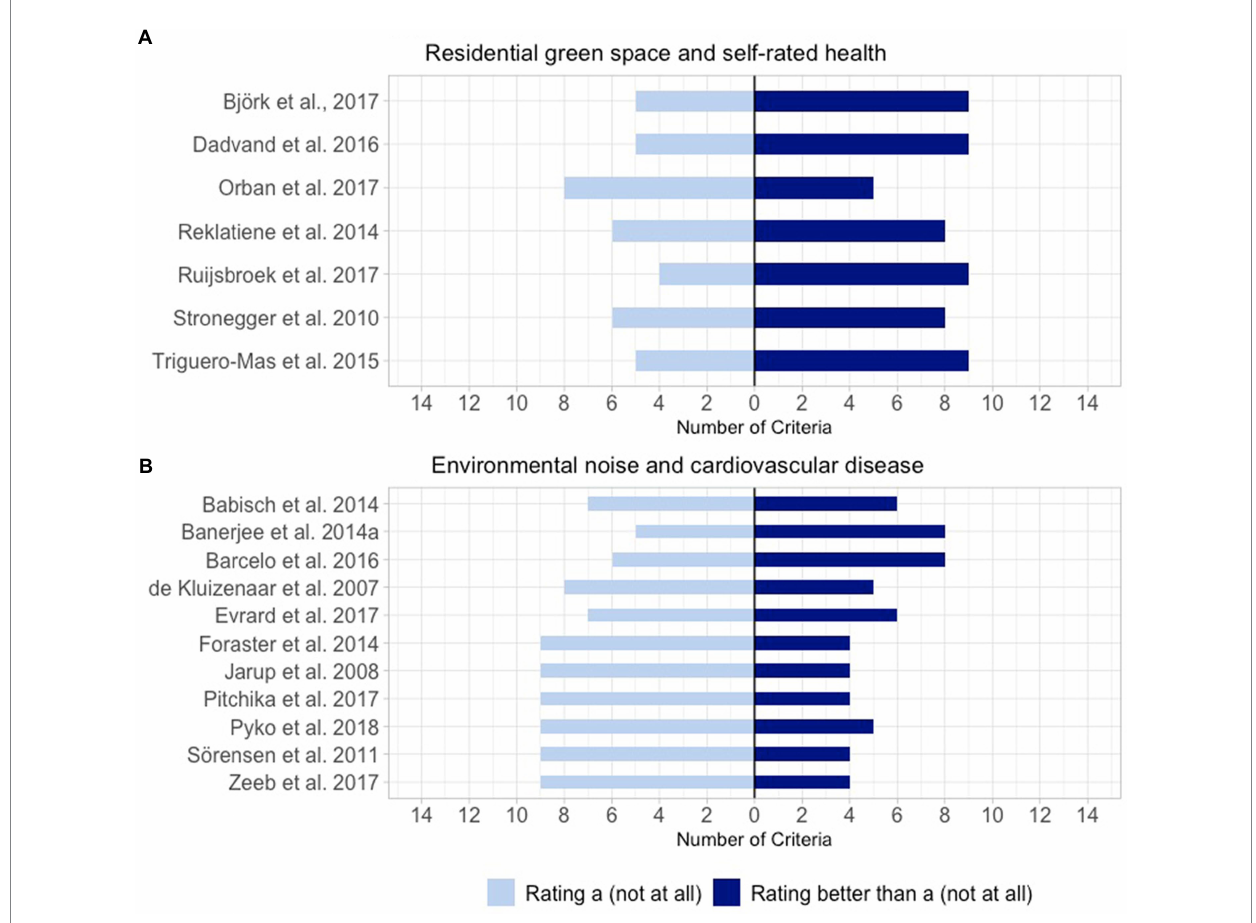
FIGURE 1 Number of criteria rated as better than “a: not at all” per publication. (A) Publications identified by the systematic review of Bolte et al. (18) assessing sex/gender in the association between residential green space and self-rated health ( n = 7). (B) Publications identified by the systematic review of Rompel et al. (15) assessing sex/gender in the association between environmental noise and cardiovascular disease ( n = 11).